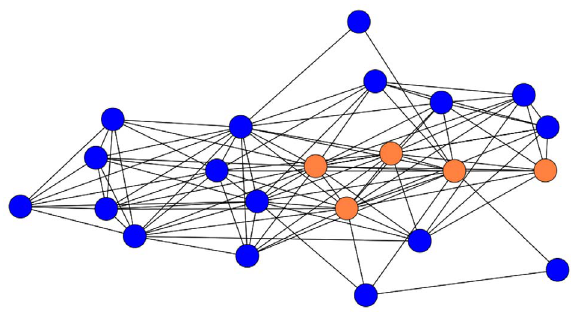
Figure 1. The network of prior contact between the group’s 22 members. Red nodes are the five scientists, blue are the 17 farmers. The figure was produced using Ucinet’s Netdraw application.